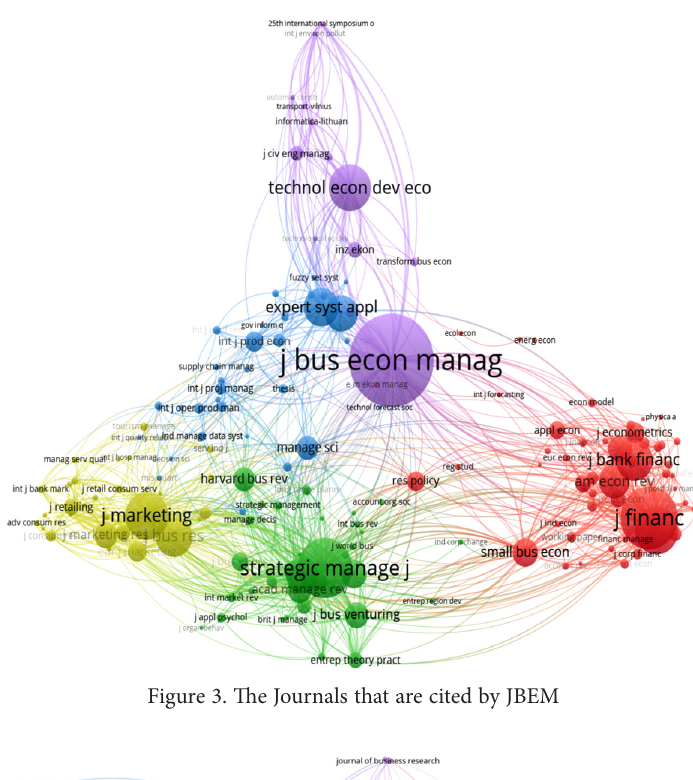
JBEMFigure 3. The Journals that are cited by